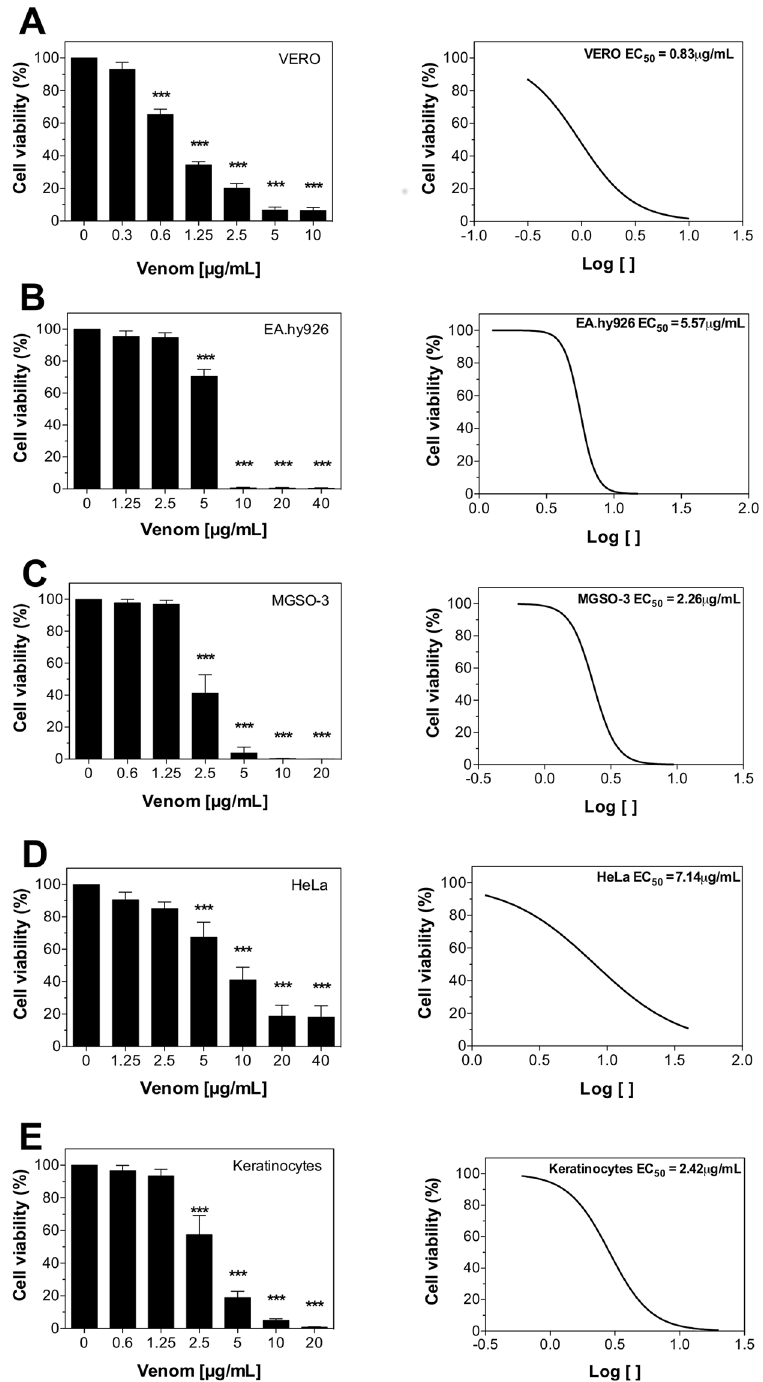
Fig 1. Lachesismuta muta venom cytotoxicity and EC 50 curves against different cell lines. (A) VERO. (B) EA. hy926. (C) MGSO-3. (D) HeLa. (E) Keratinocytes. Cells were treated for 24 hours with serial dilutions of venom (0.3– 40 μg/mL). Cell viability was analysed with Alamar Blue assay. The software GraphPad Prism 5 was used to calculate venom EC 50 . Data are represented as means ± SEM (n = 3, data were collected from three independent experiments). Venom-treated groups were compared using one-way ANOVA ( (cid:3)(cid:3)(cid:3) p < 0.001).